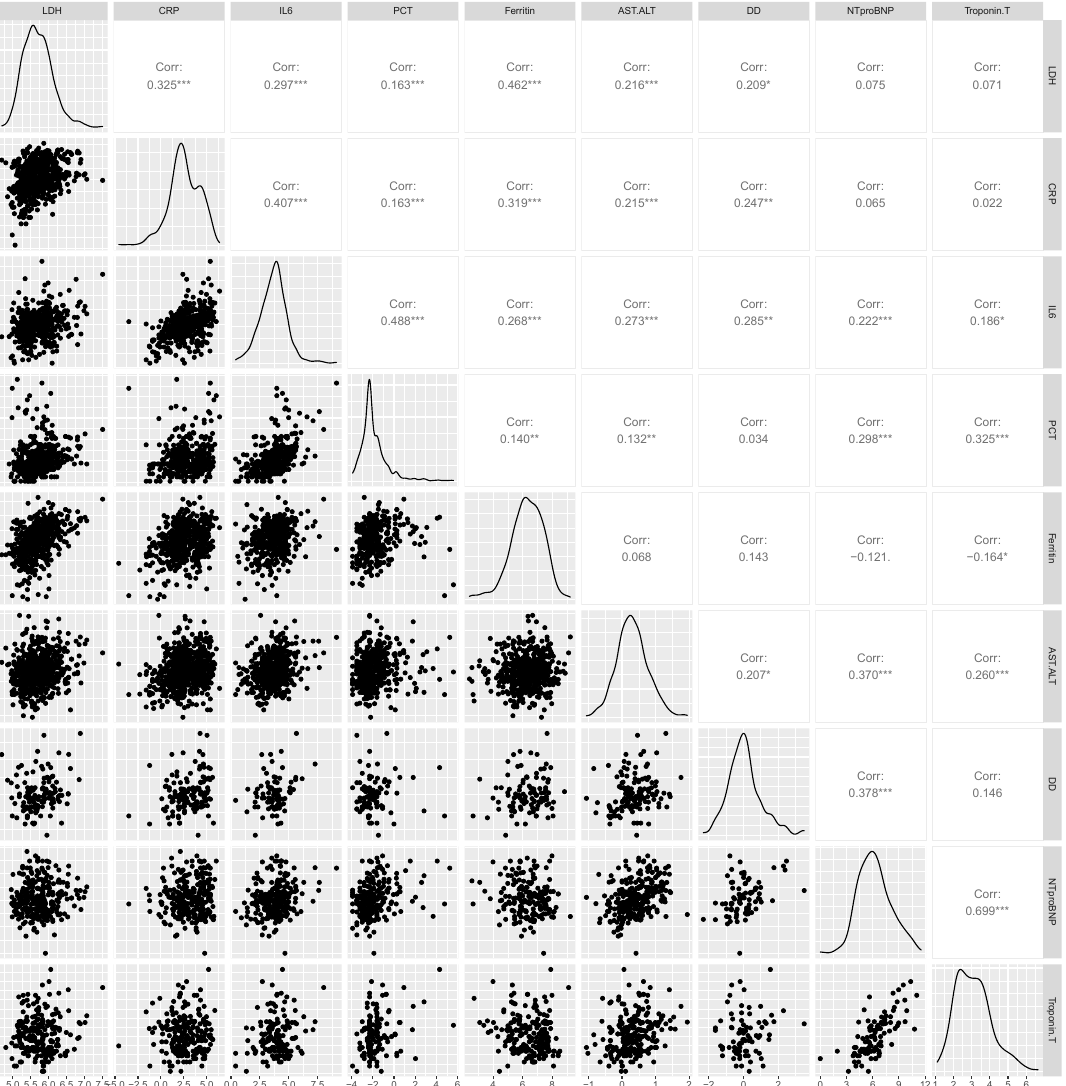
Figure 2. Pearson correlation plots of log-transformed biomarkers. X and Y labels correspond to log-transformed values of biomarkers. Corr: corresponds to Pearson correlation coefficient. LDH: lactate dehydrogenase; CRP: C-reactive protein; IL6: interleukin 6; PCT: procalcitonin; AST: aspartate aminotransferase; ALT: alanine aminotransferase; NT-proBNP: N-terminal pro-brain natriuretic peptide. * The correlation is significant at < 0.05. ** The correlation is significant at < 0.01. *** The correlation is significant at < 0.001.